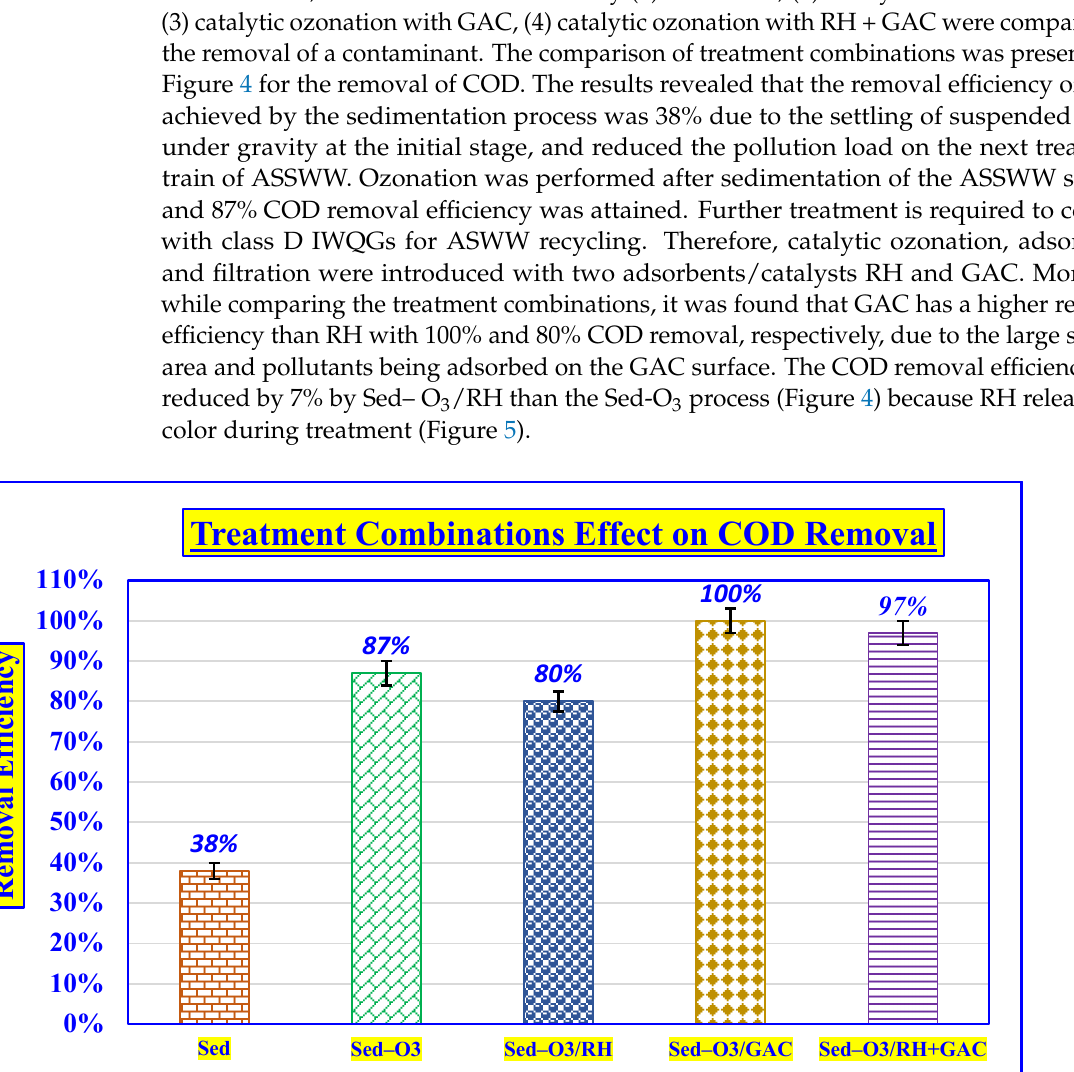
Figure 5. Treated samples of ASSWW by three treatment combinations. The maximum 100% removal efficiency was achieved by the Sed–O 3 /GAC process with an adsorbent amount of 400 g. To make an economical treatment combination, the combined effect of adsorbents (RH + GAC) was studied due to the higher cost of GAC. The adsorbent quantity was reduced by 50% and 200 g of each catalyst was applied. It was